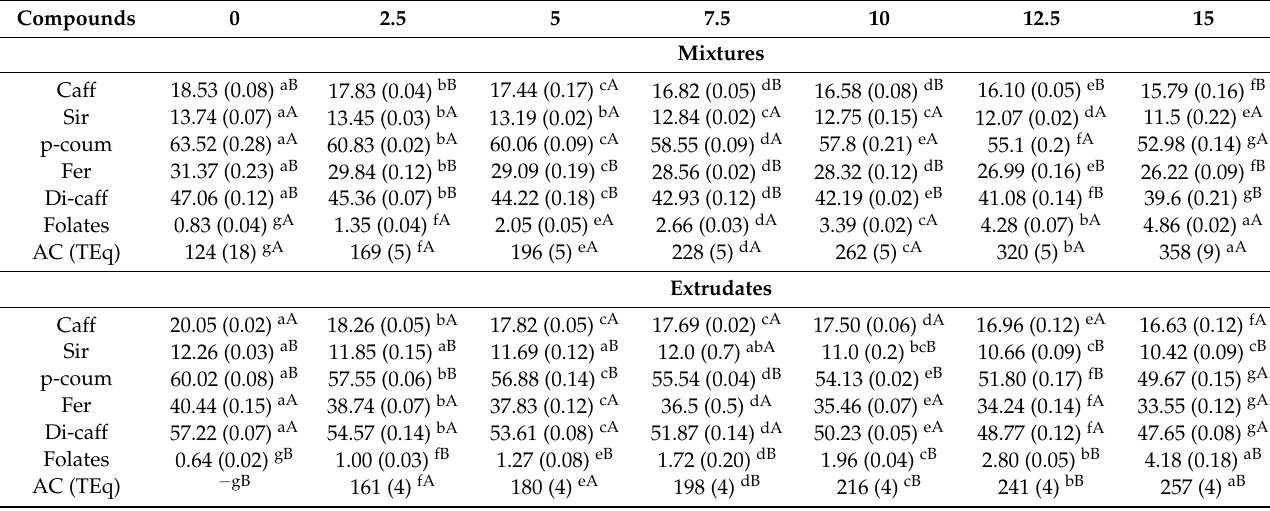
For each compound, the same small letter in superscript within a row indicates homogeneous groups established by ANOVA ( p < 0.05) comparing MS % (0, 2.5, 5, 7.5, 10, 12.5, and 15) in mixtures or extrudates. For each MS % (0, 2.5, 5, 7.5, 10, 12.5, or 15) and compound, the same capital letter in superscript within a column indicates homogeneous groups established by ANOVA ( p < 0.05) comparing mixtures and extrudates. All data represent the mean of three